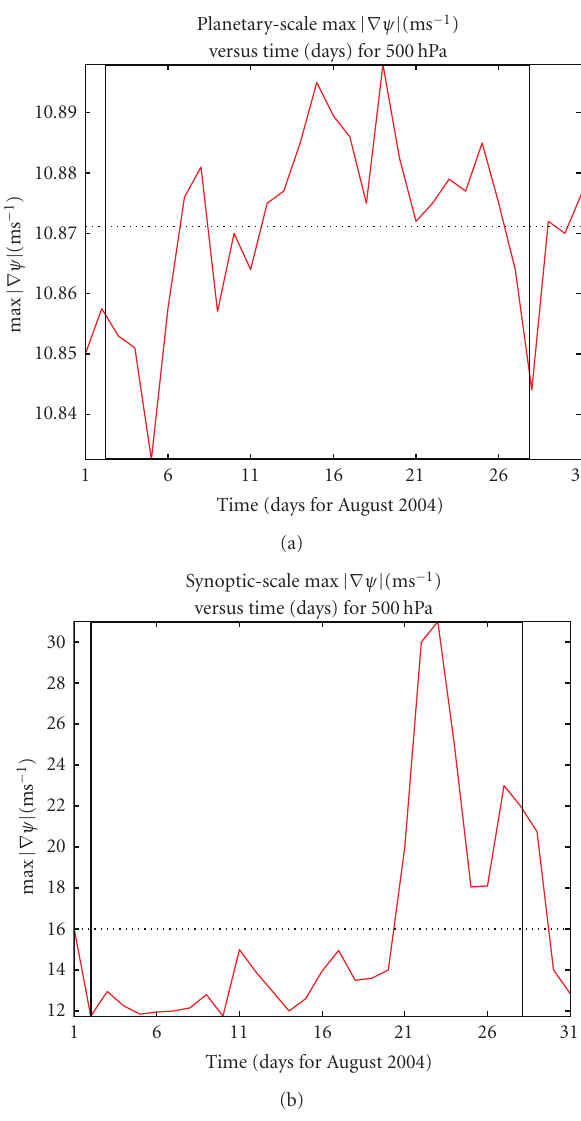
Figure 5: (a) The blocking area averaged enstrophy using (2) for the blocking event displayed in Figure 3 which occurred during 05– 28 August 2004. The relative stability level changes at onset (02– 05 August) and at decay (20–28 August) stages. The dash dotted horizontal line defines the monthly mean value. The left vertical line marks the beginning, whereas the right vertical line marks the end of the selected blocking event; (b) same as Figure 5(a) except for the synoptic-scale height.